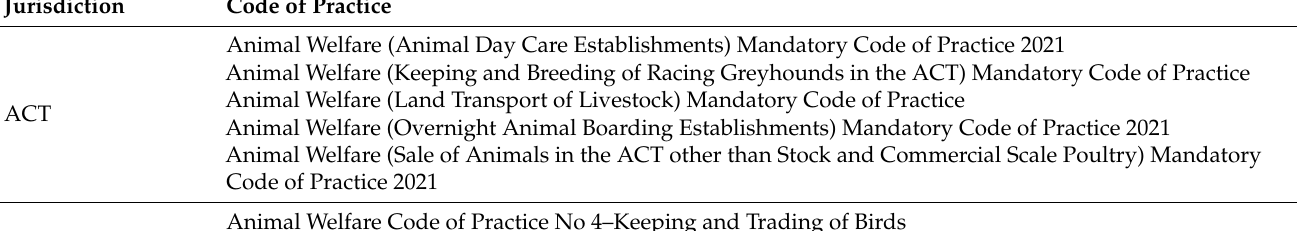
Table A1. Compulsory codes of practices included for analysis (n =